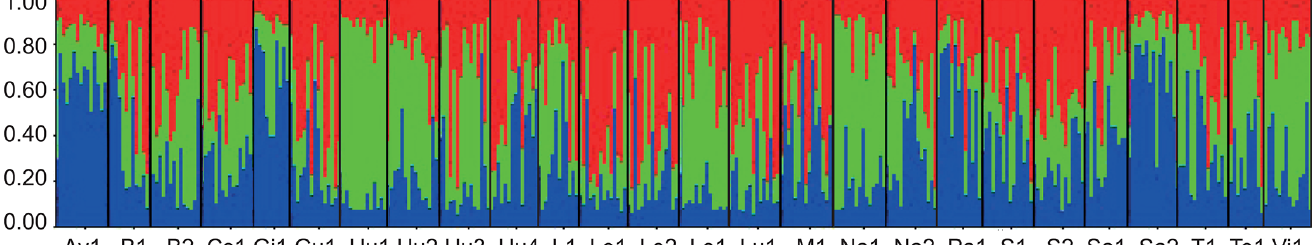
Fig 4. Percentage assignment of each individual (represented by vertical bars) to each of the three genetic clusters (represented by different colours) inferred by the program Structure [43]. See Table 1 for population